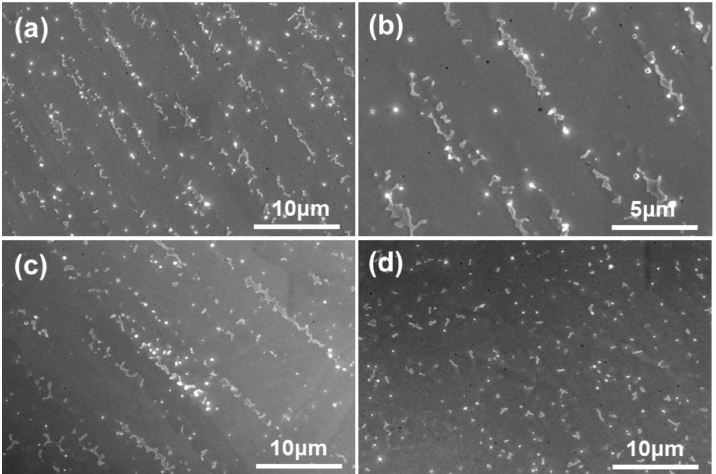
Figure 5. SEM micrographs of samples after electrolytically polishing. ( a , b ) Particle morphology of the SDS sample; ( c , d ) particle morphology of two adjacent layers of the CDS